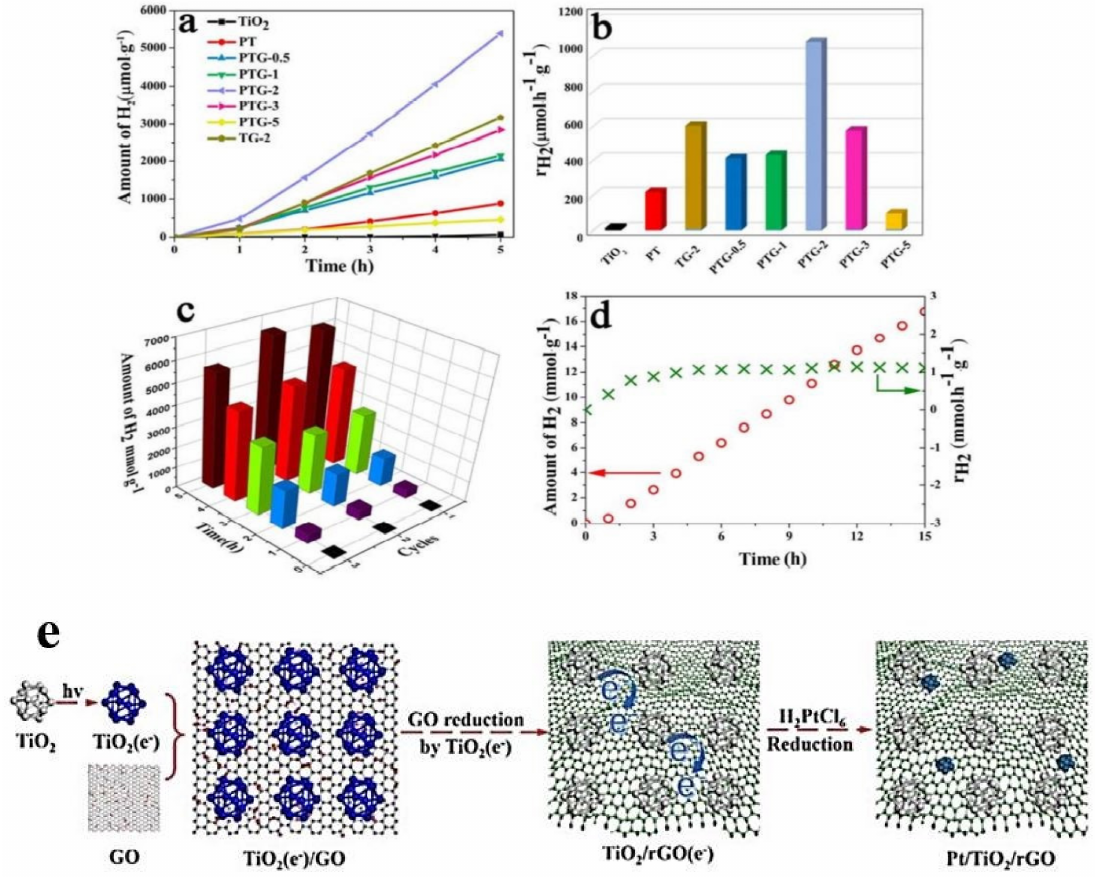
Figure 11. ( a ) H 2 generation profile, ( b ) rate of hydrogen generation for different samples, ( c ) stability study, ( d ) H 2 generation from a continuous measurement for Pt/TiO 2 /rGO-2%, and ( e ) schematic preparation procedure of Pt/TiO 2 /rGO nanocomposite. (Reprinted with permission from reference [136]. Copyright 2017,